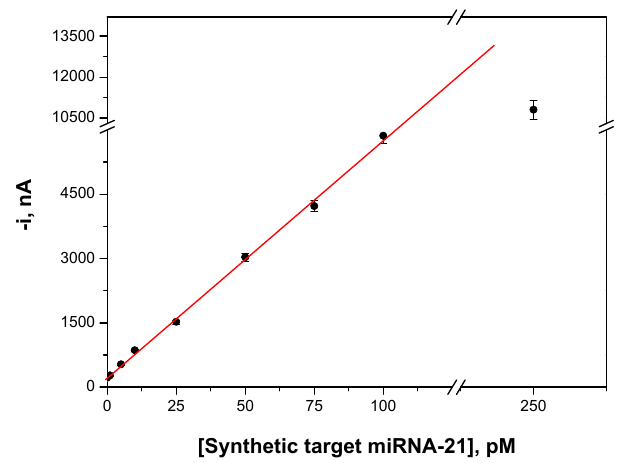
Figure 4. Calibration plot constructed for miRNA-21 with the developed electrochemical biosensor. Error bars estimated at triple the standard deviation of three replicates. Table 3. Analytical characteristics obtained for the determination of miRNA-21 with the developed biosensor. Parameter Value